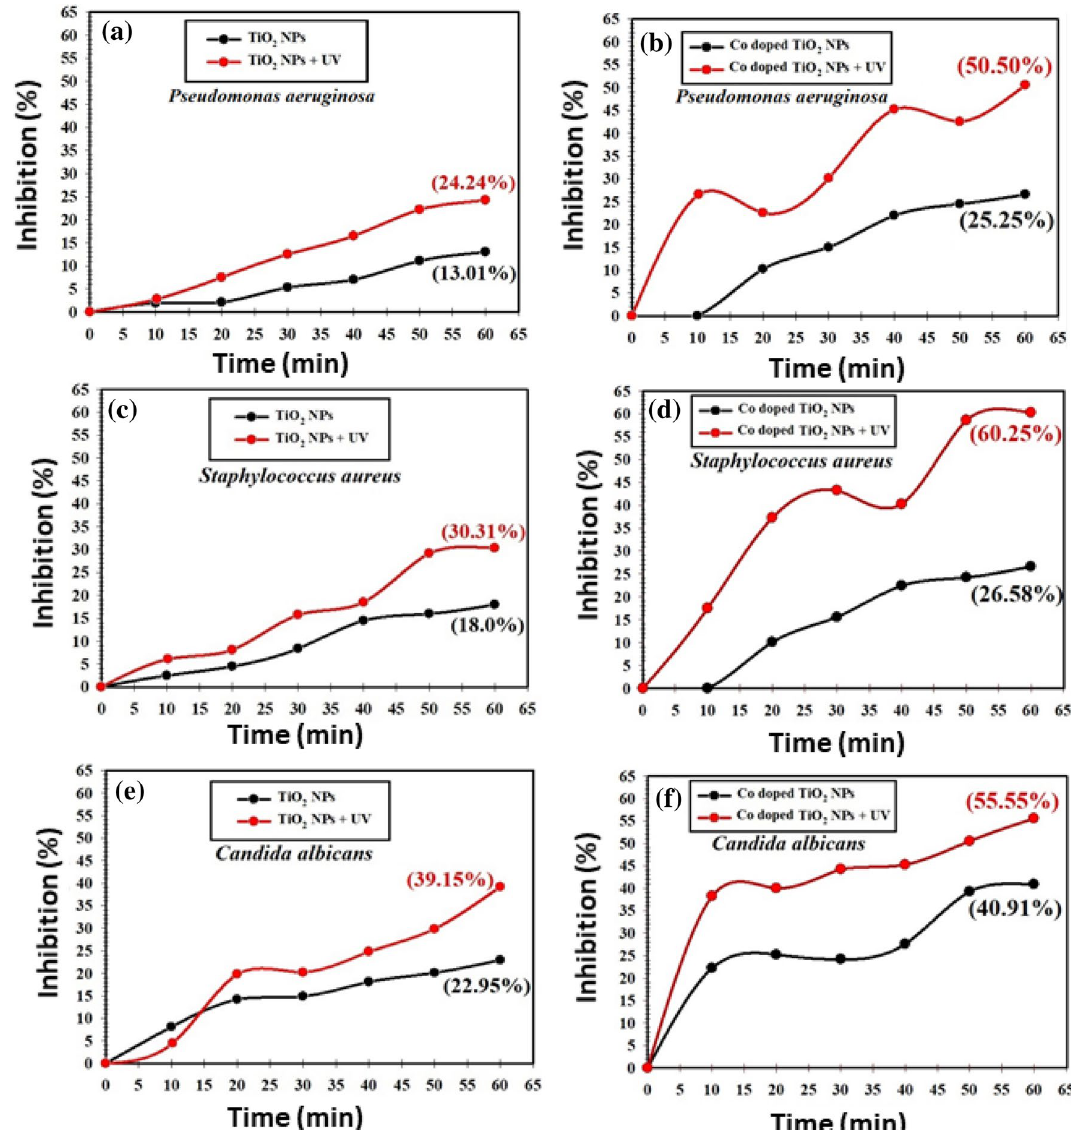
Figure 6. Antimicrobial effect under UV-irradiation effect against different pathogenic microbes, where Pseudomonas aeruginosa ( a , b ), Staphylococcus aureus ( c , d ), and Candi1da albicans ( e , f ), using of bare TiO 2 , and Co-doped TiO 2 in liquid media,